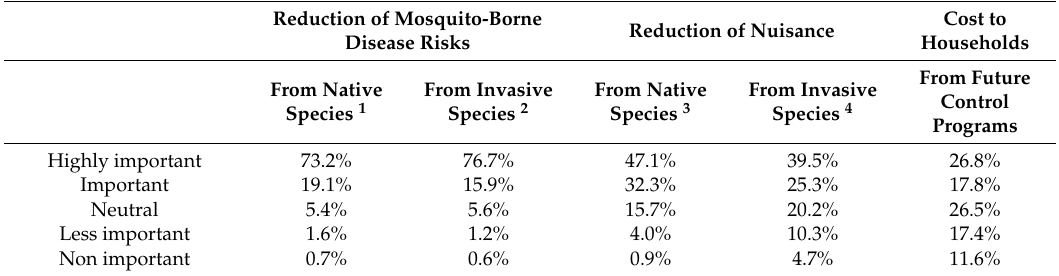
Table 2. Individuals’ rating of the objectives of mosquito control programs (web-survey results).